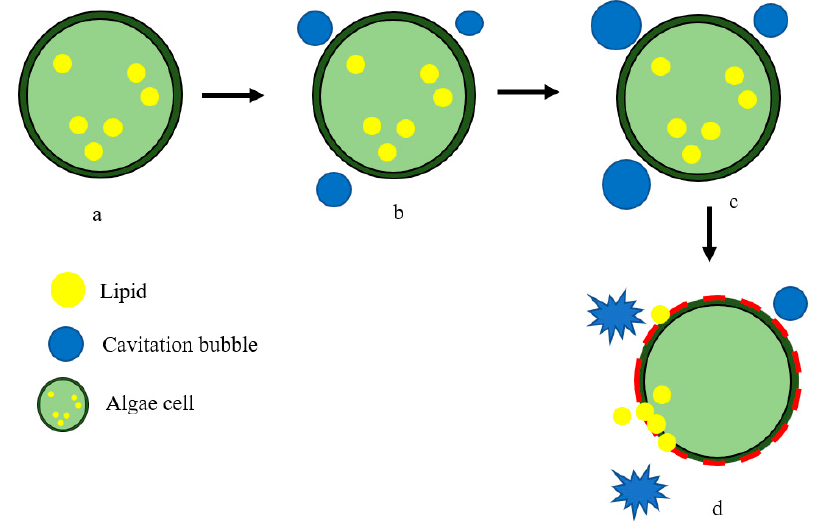
Figure 5. Disruption of algal cell using ultrasound: ( a ) condition of algal cell prior to disruption; ( b ) formation of cavitation bubbles; ( c ) growth of cavitation bubbles; and ( d ) breakdown of algal cell wall and release of lipids.